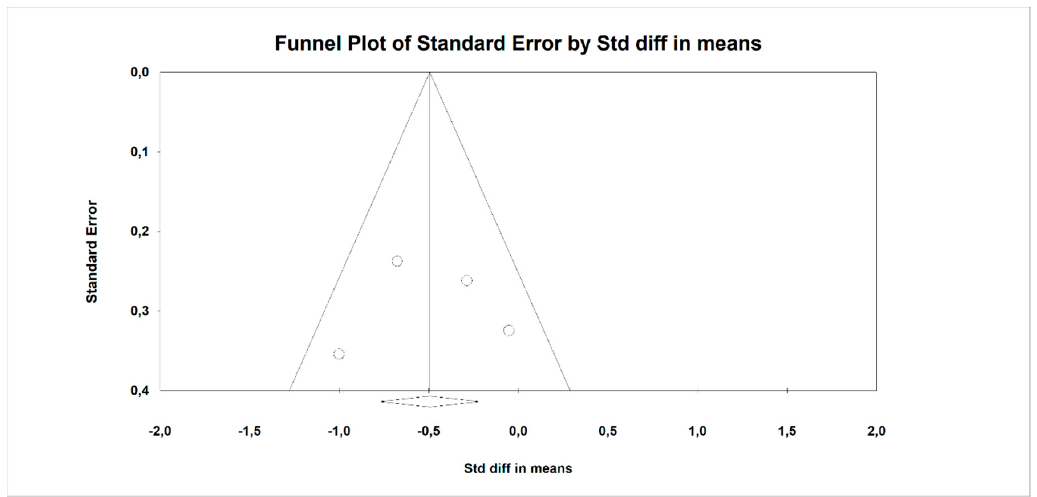
Figure 4. Funnel plot for endpoint BMI (standardized mean difference) in the present meta-analysis. Egger’s test: p = 0.957.